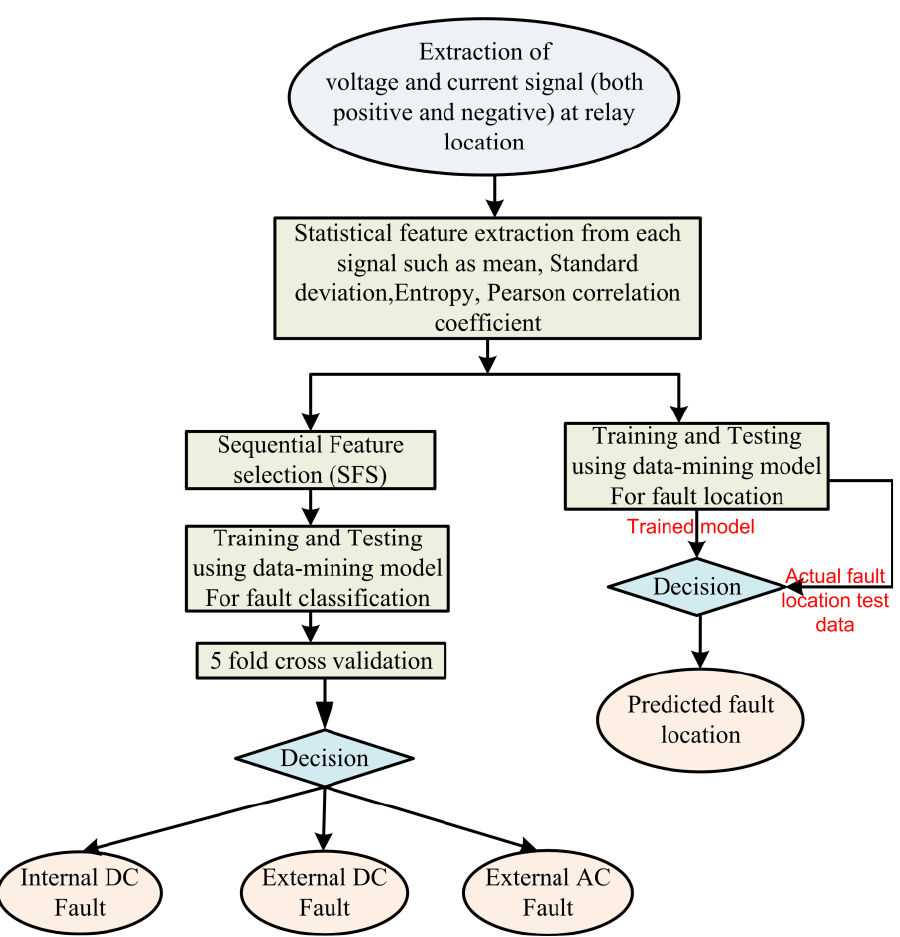
Figure 2. Flowchart of the proposed methodology of HVDC fault classification and location.